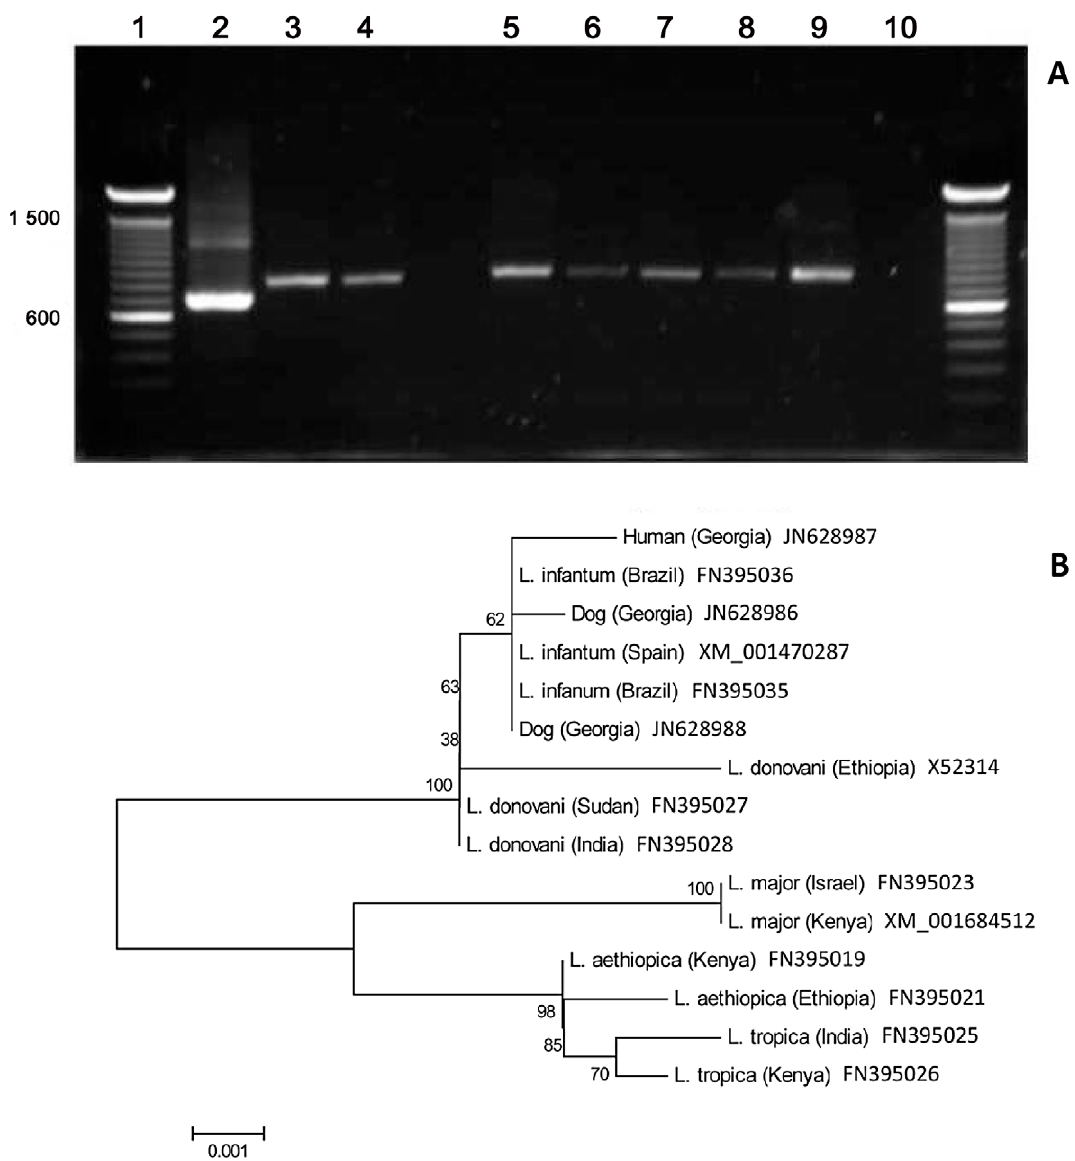
Figure 3. Identification of Leishmania species isolated from a human and dogs. (A) kDNA-PCR performed on DNA extracted from the bone marrow of a sick child and bone marrow cultures of five representative dogs. Lane 1, DNA size marker (100 bp ladder); lane 2, L. major (MHOM/IL/80/ Friedlin); lane 3, L. infantum (MHOM/ES/00/UCM-1); lane 4, bone marrow, child, Tbilisi; lanes 5–9, bone marrow, dogs, Tbilisi; lane 10, negative control. (B) Phylogenetic analysis of Leishmania 70 kDa heat-shock protein ( HSP70 ) genes. The sequences are represented by the Leishmania sp. , country of origin in parentheses and GenBank nucleotide accession number. Node values indicate branch support.